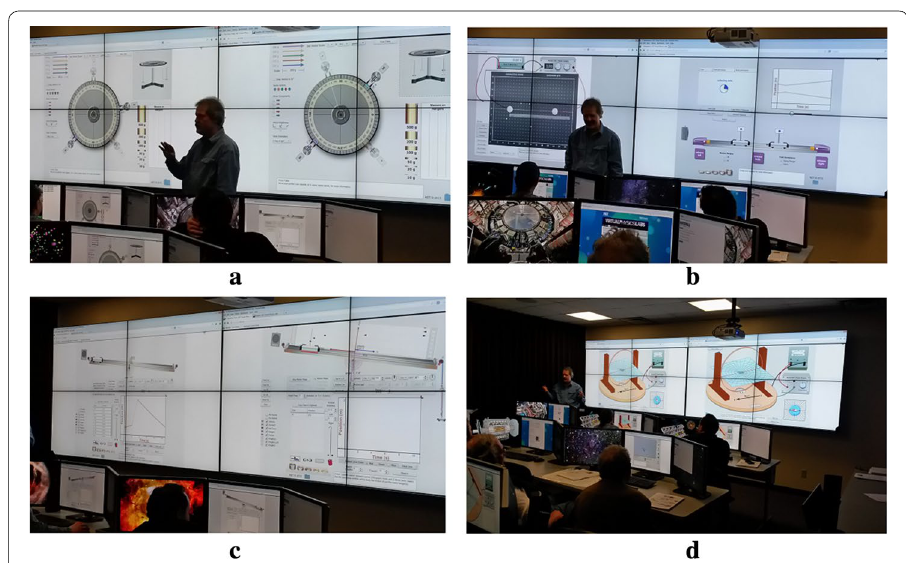
Fig. 27 Instructor using Hiperwall for conducting virtual Physics